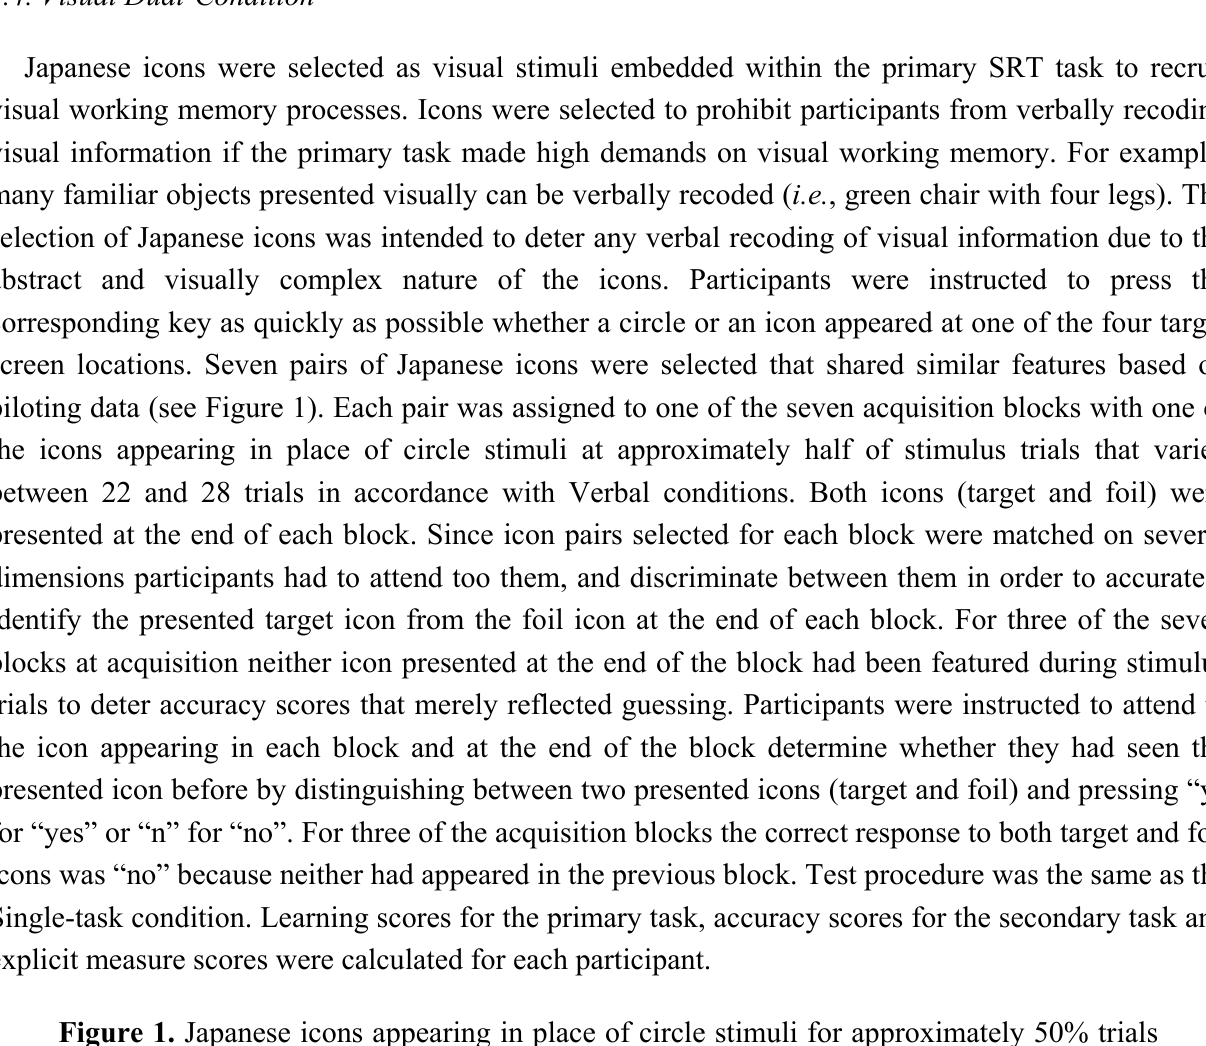
Figure 1. Japanese icons appearing in place of circle stimuli for approximately 50% trials in a SRT task acquisition blocks ( n = 7) for Visual and Visual-Spatial dual-task